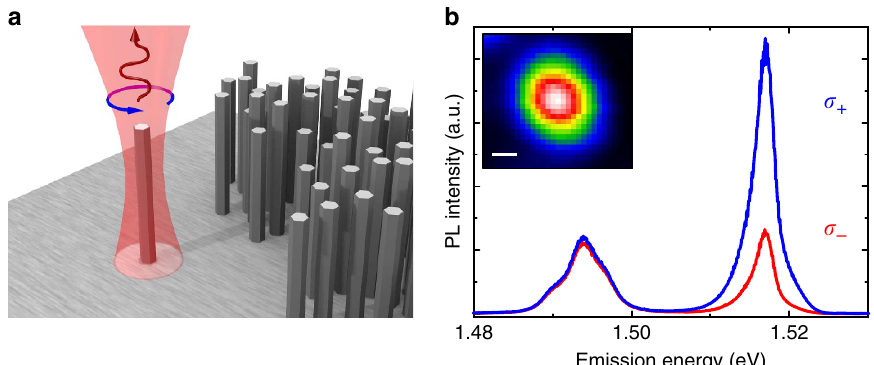
Figure 2 | Optical spin orientation in single WZ GaAs NWs. ( a ) Schematic representation of the measurement geometry used for optical orientation measurements in our experiment. An isolated, free-standing NW is individually excited by a tightly focused circularly polarized laser beam propagating parallel to the NW axis. Helicity-resolved PL emission is detected in confocal configuration along the NW axis. ( b ) Polarization-dependent m -PL spectra of a single, free-standing WZ GaAs NW at 4.2K under s þ circularly polarized excitation. While the substrate peak at B 1.494eV holds no significant circular polarization, the NW emission at 1.517eV is highly polarized with a degree of polarization of B 54%, indicating efficient optical orientation of spins in the wire. Inset shows an area scan of the integrated PL intensity in the vicinity of this NW in false colour coding, evidencing single NW spectroscopy. Scale bar, 1 m m.